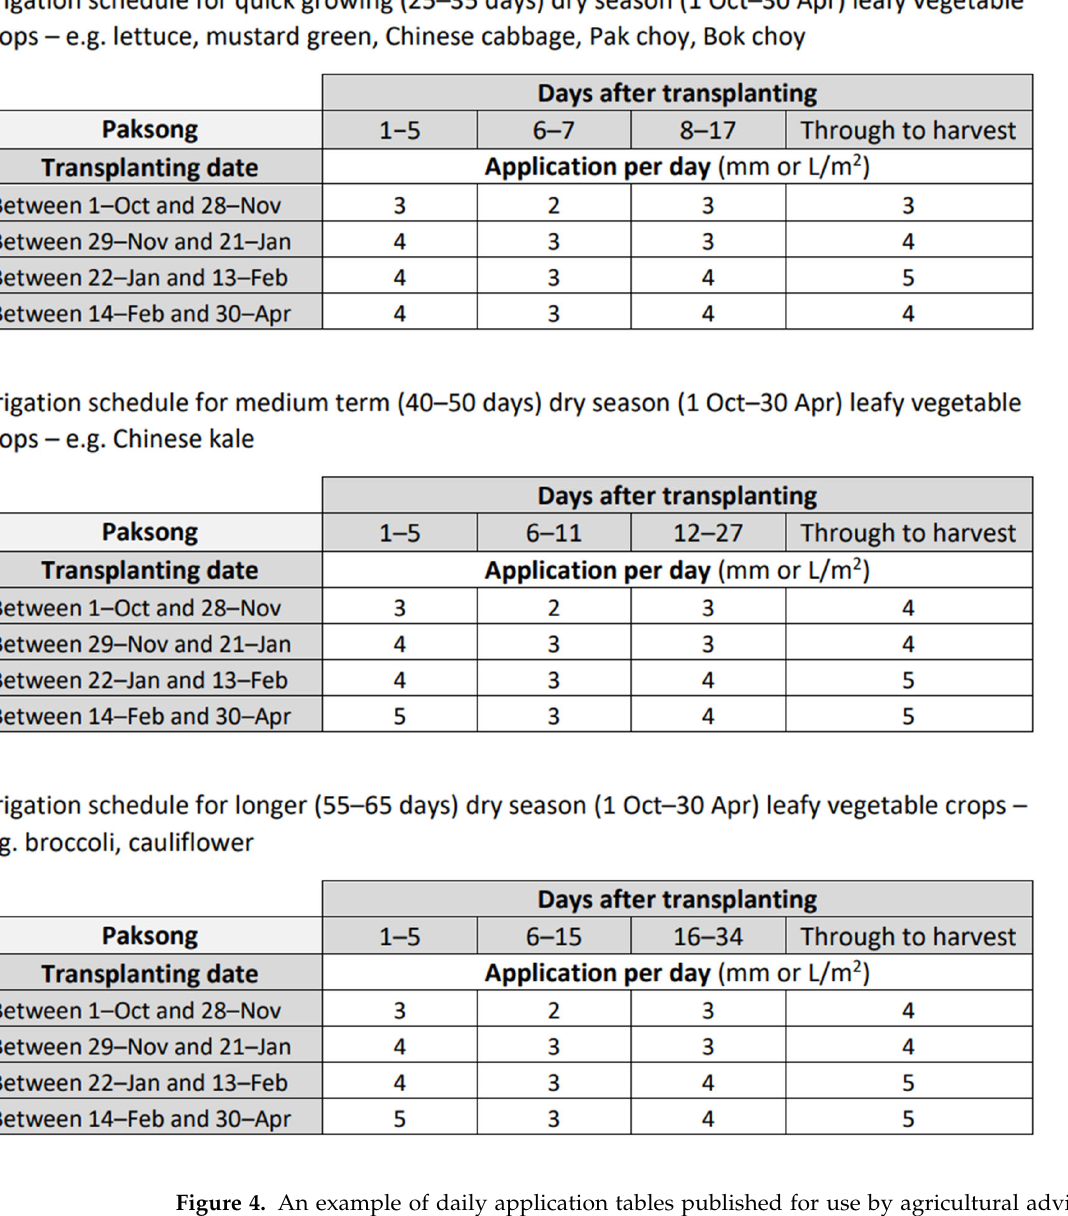
Figure 4. An example of daily application tables published for use by agricultural advisors and smallholder farmers (for Paksong district, Champasak Province, Laos) showing recommended daily application rates for leafy vegetables of three different growth durations.